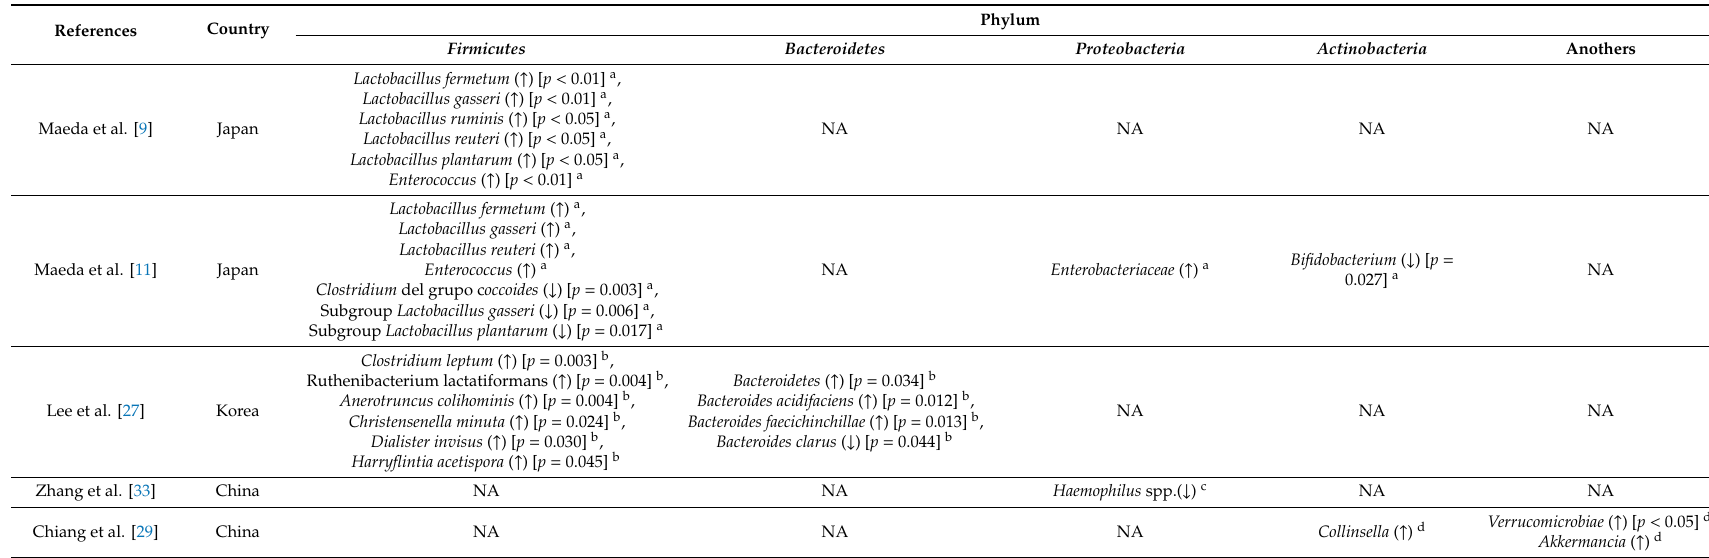
Table 2. Studies of gut microbiota composition in under therapy RA